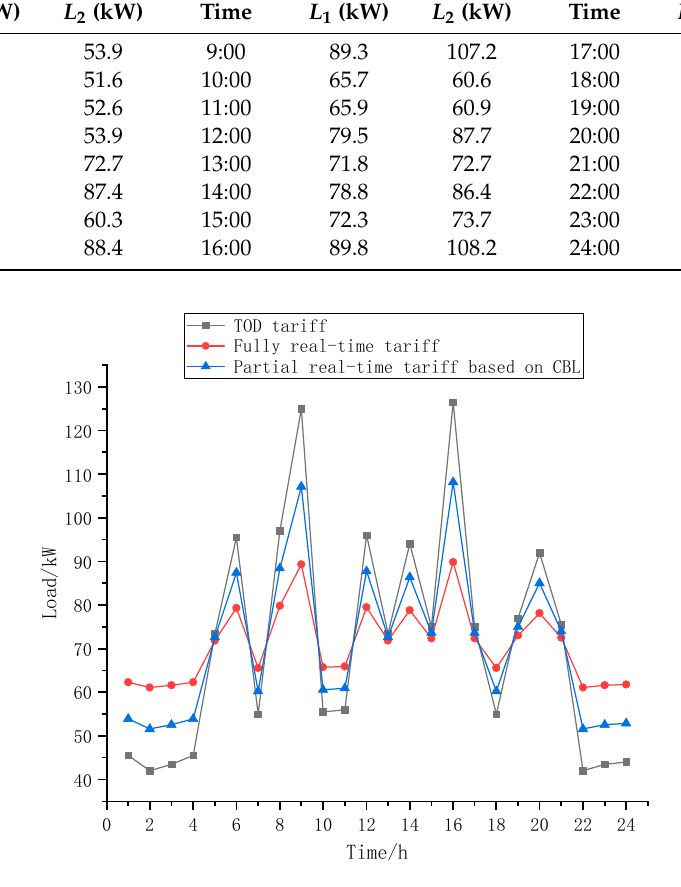
Figure 4. User’s load response with real-time price.